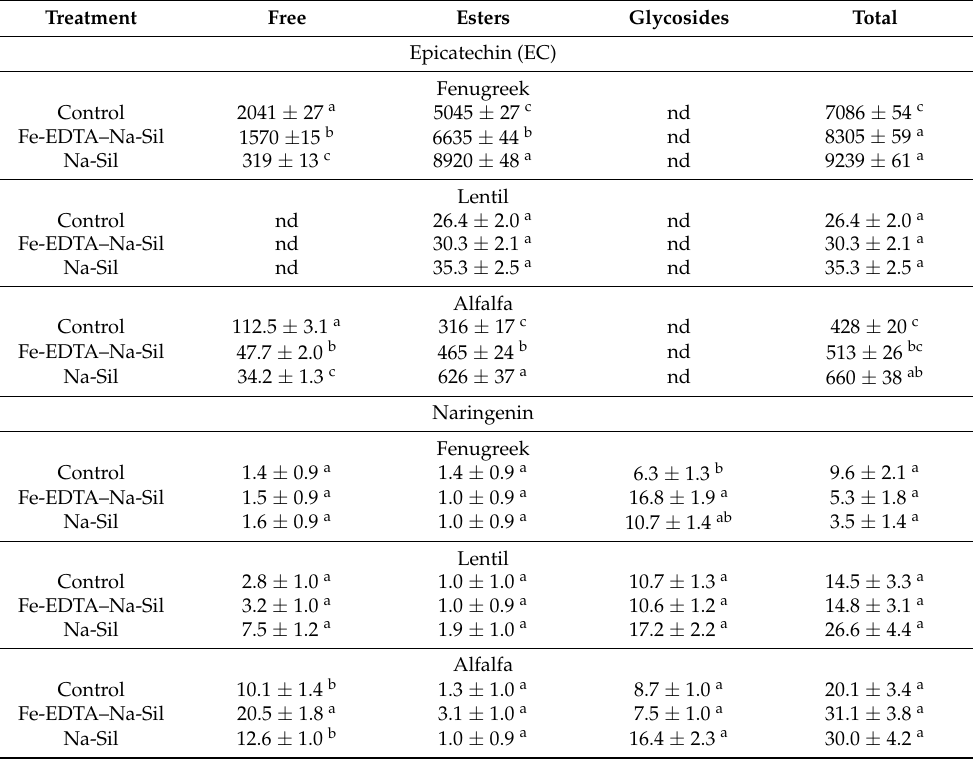
Table 1. The contents of epicatechin (EC) and naringenin (free and released from ester and O - glycoside forms) in legume sprouts ( µ g/g DW) treated with elicitors during growth. Treatment Free Esters